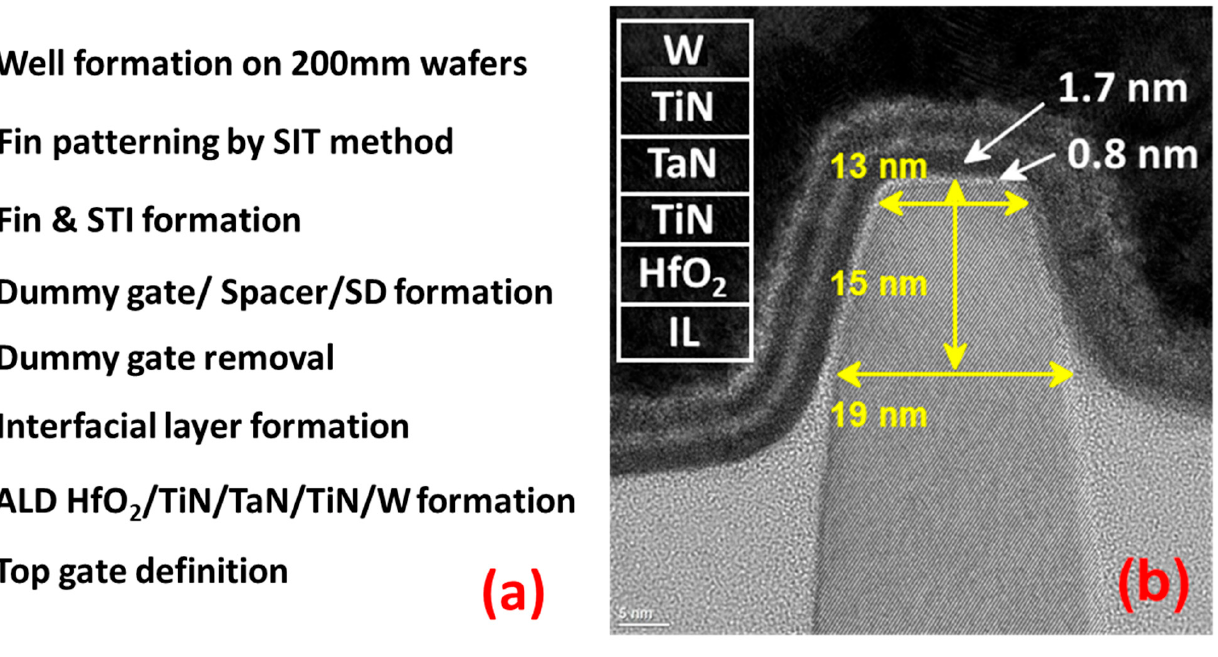
Figure 1. ( a ) The process of p-FinFET with replacement metal gate (RMG). ( b ) TEM image of p-FinFET across channel direction.